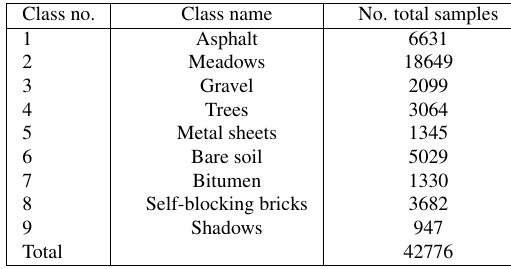
Figure 2. Hyperspectral Indian pines image and its ground-truth map.